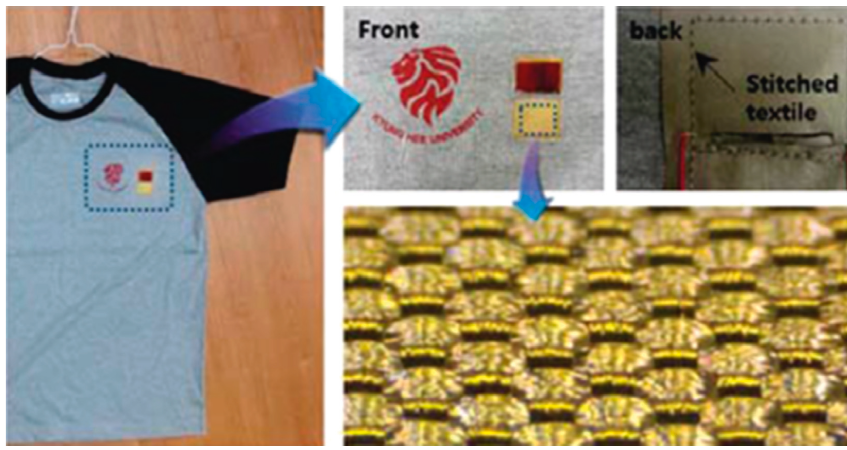
Figure 8: Method of integration of the photovoltaic cell with a T-shirt [32].